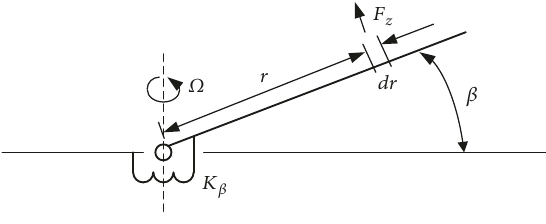
Figure 3: Rotor blade fl apping